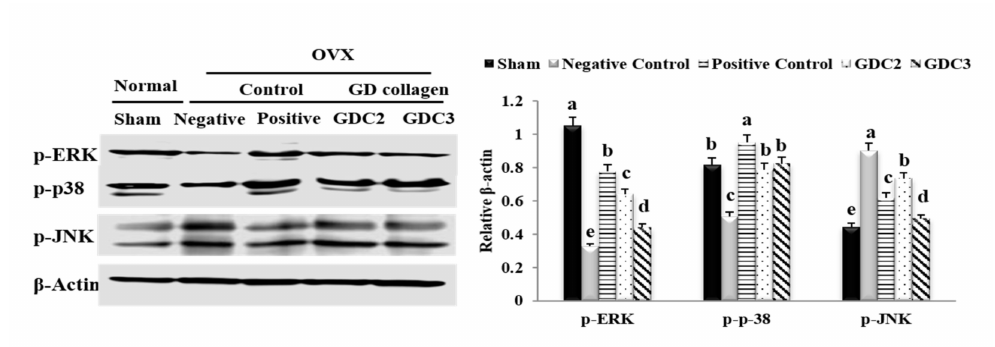
Figure 7. E ff ect of GD collagen on the MAPK signaling pathway. p-ERK, p-p38, and p-JNK protein expression in rats’ tibias were determined by Western blot analysis. GDC2, GD collagen 2 g / kg and GDC3, GD collagen 3 g / kg. Expression was quantified using ImageJ, relative to that of β -actin. The values represent the mean ± standard deviation. Values with di ff erent letters di ff ered significantly using Duncan’s multiple range test ( p <